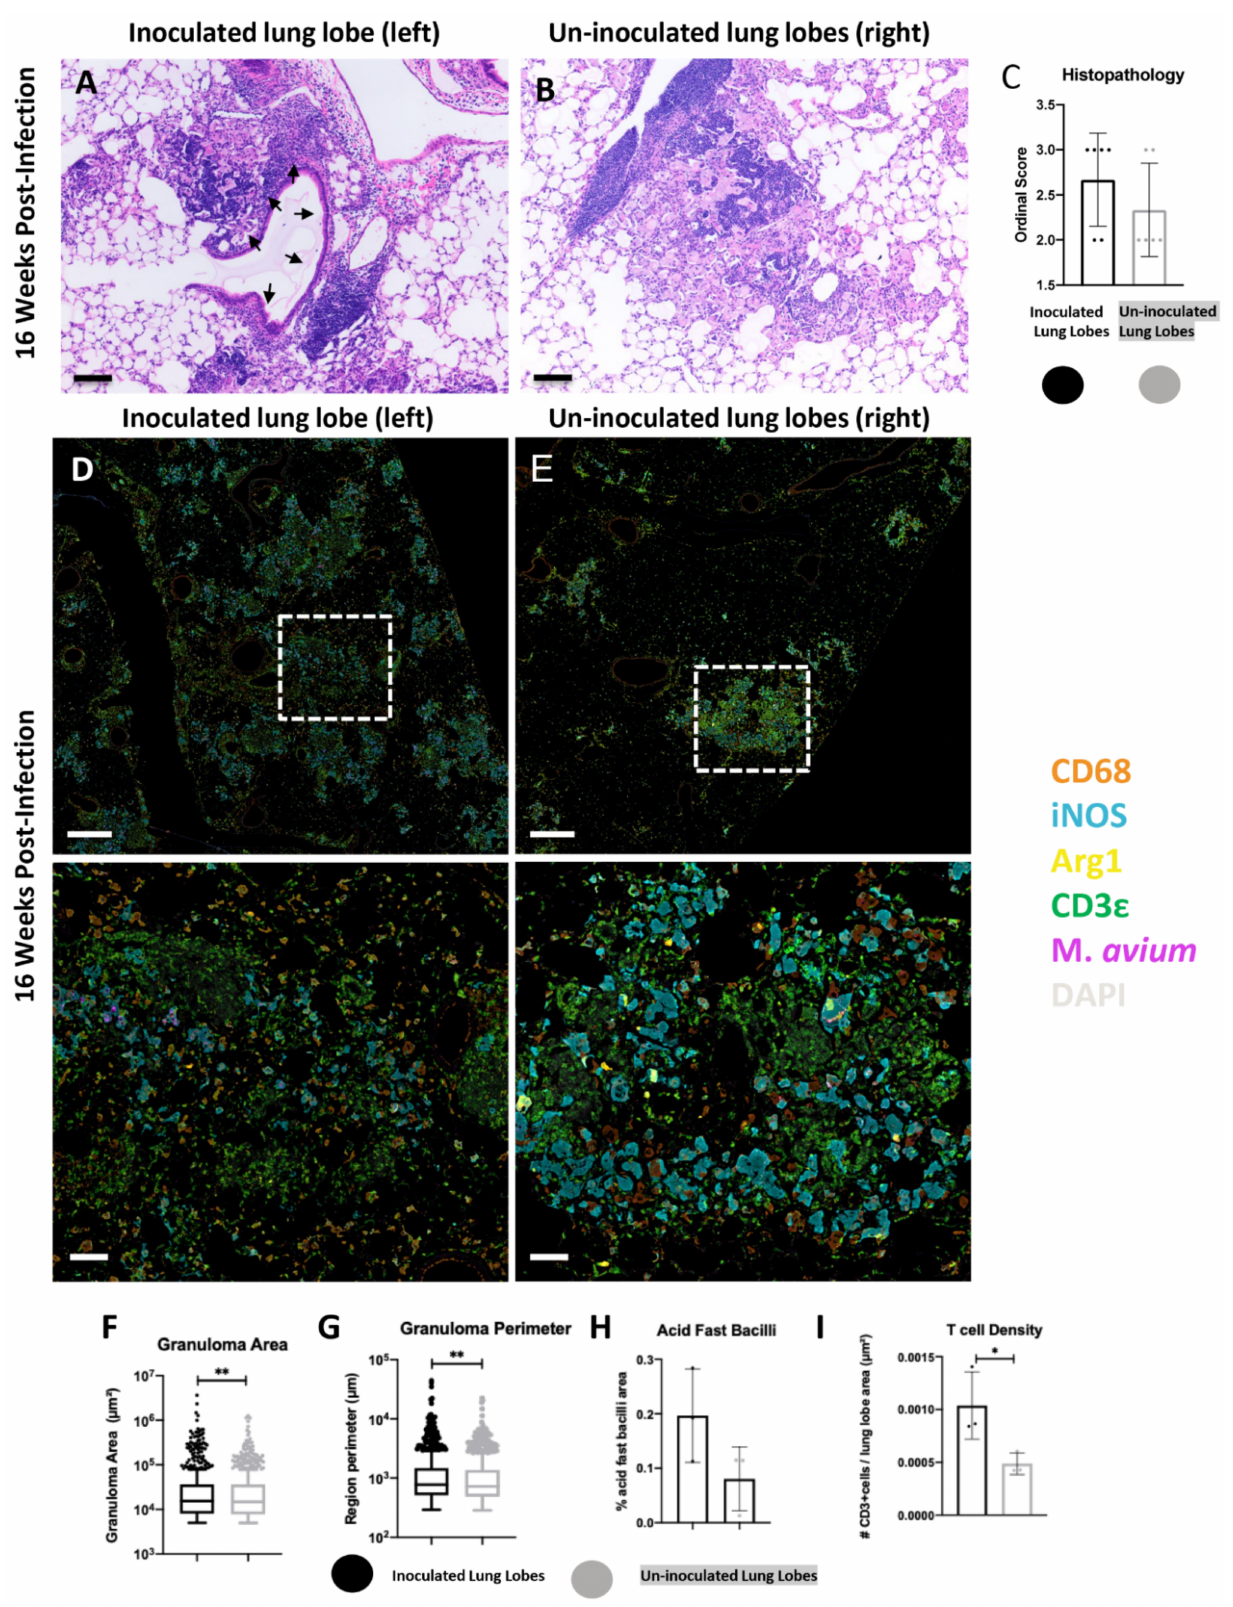
Figure 2. Comparison of inoculated ( left ) and un-inoculated lung lobe ( right ) lesions at 16 weeks-post infection (wpi) following unilateral left mainstream intrabronchial M. avium inoculation in B6.Sst1S